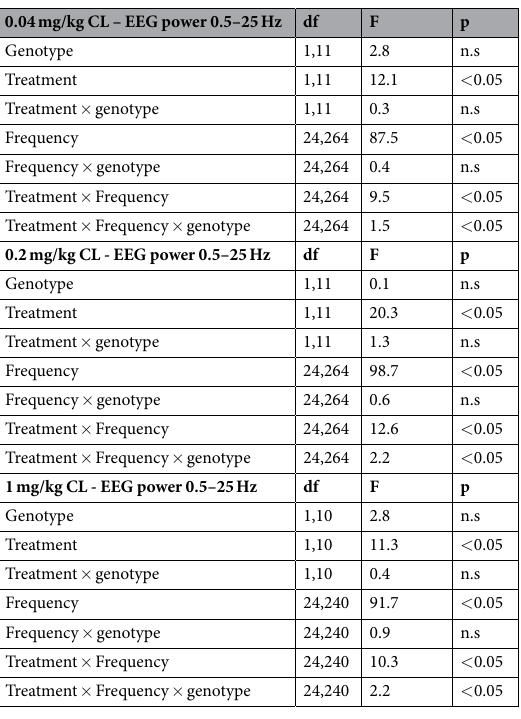
Table 4. Effects of CL-316,243 on the NREMS EEG power spectrum averaged for the first 6 h in WT and UCP-1 KO mice – statistical results.